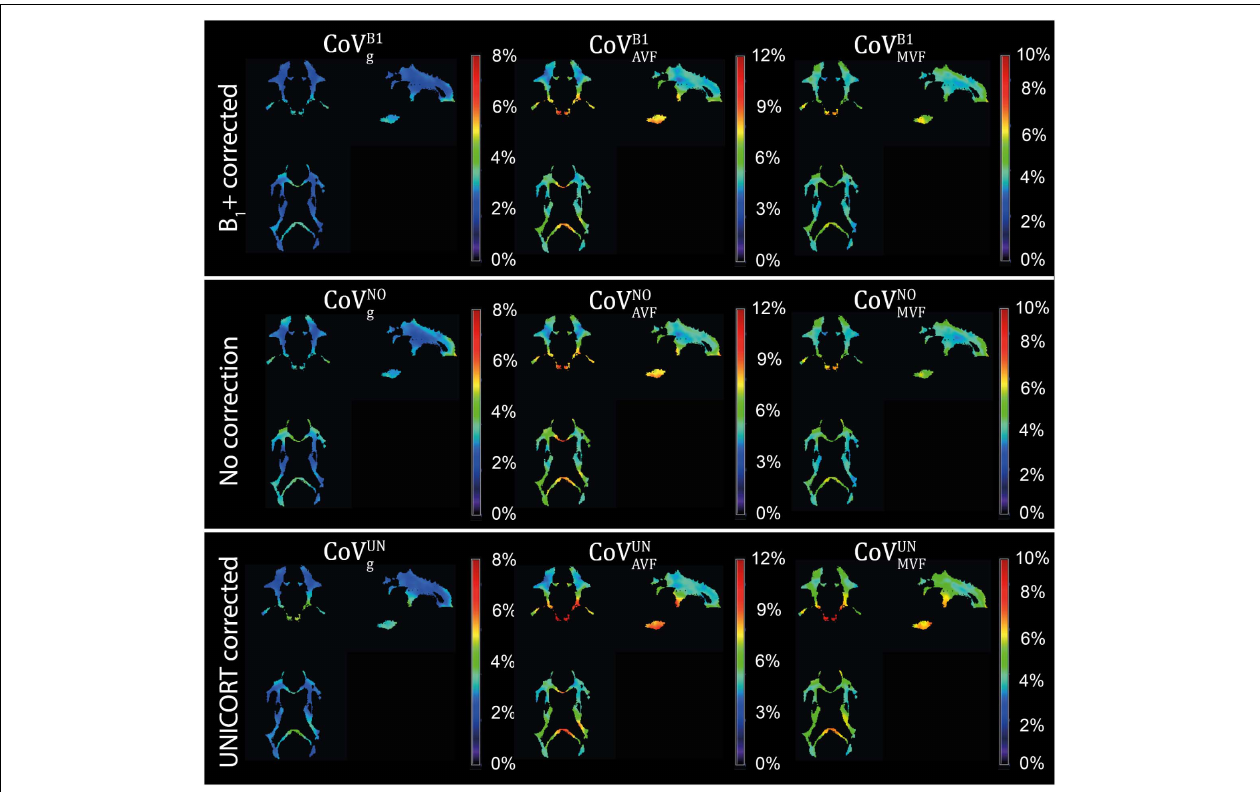
FIGURE 10 | Coefficient of variation (CoV) maps of g MR , AVF MR , and MVF MR with B 1 + correction (CoV B1 g , CoV B1 AVF , and CoV B1 MVF ), no correction (CoV NO g , CoV NO AVF , and CoV NO MVF ), and UNICORT B 1 + correction (CoV UN g , CoV UN AVF , and CoV UN MVF ). CoV maps, expressed in percentage, were computed as the voxel-wise ratio between the group mean and group standard deviation maps of the normalized g MR , AVF MR , or MVF MR . The voxel-wise computation of CoV is restricted to the group WM mask (cf. section “Definition of White Matter Masks”). Shown are a single coronal (y = 91), sagittal (x = 100), and axial (z = 85) slice.